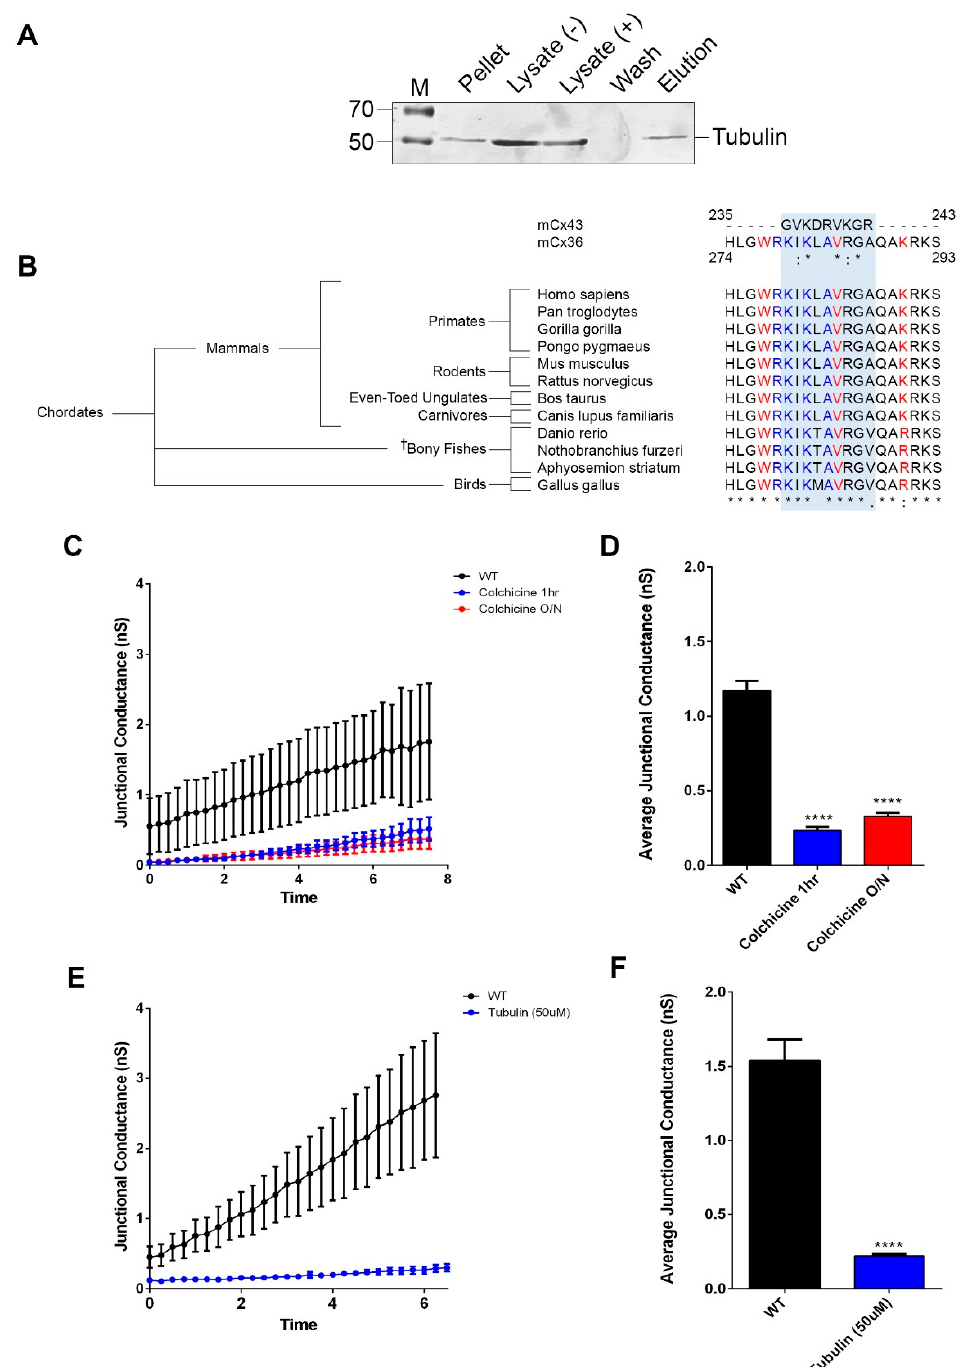
Figure 1. Tubulin interaction at the Cx36 carboxyl terminus potentiates electrical plasticity. ( A ) Full-length Cx36 protein was expressed as a fusion protein with the BirA* ligase to perform a BioID assay using Neuro-2a cell lysate. Lysates were subjected to western blot analysis before ( − ) and after ( + ) the addition of streptavidin-conjugated beads. Immunodetection identified tubulin as an interaction candidate of Cx36. ( B ) Sequence alignment of the tubulin-binding motif confirmed in Cx43 elucidated the potential Cx36 interface, localized to the Cx36 carboxyl terminus (CT). The putative binding motif of Cx36, shaded in blue, demonstrated robust conservation across orthologs belonging to the major vertebrate Chordata subphylum. The † symbol indicates the selective use of the Cx35b protein corresponding to the gjd2b gene. Conserved residues within the Cx36 CT are indicated by the asterisks. Both CaM- and CaMKII-binding sites appeared to share some overlap with the tubulin-binding motif, potentially indicating competitive or cohesive binding mechanisms. The CaMKII-binding motif is outlined in blue, and the CaM motif is outlined in red. ( C , D ) Neuro-2a cells cultured in a bathing